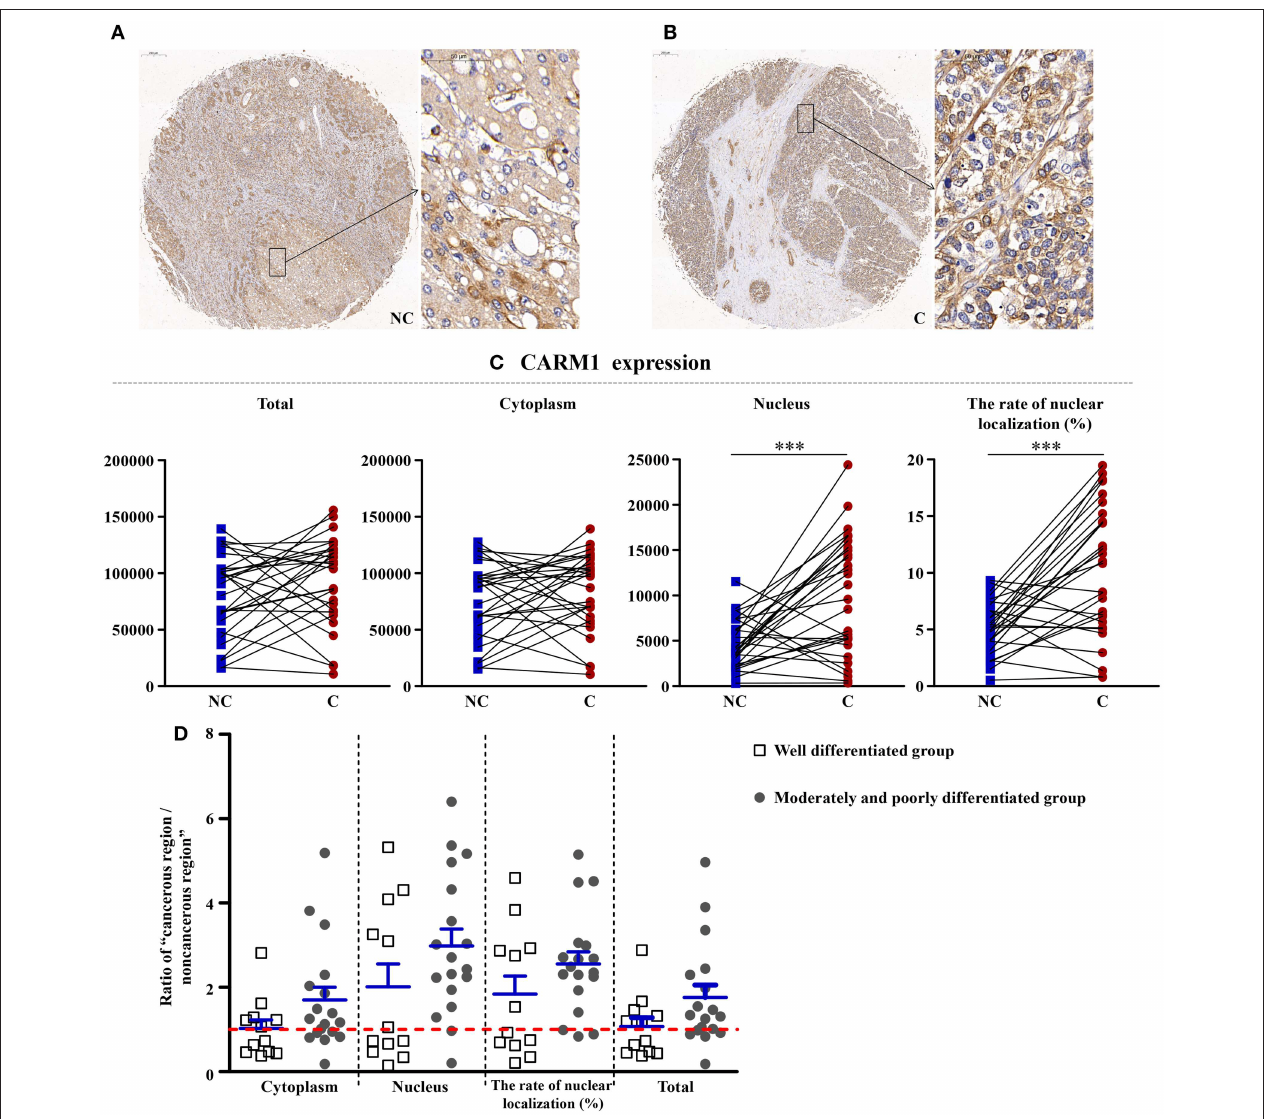
FIGURE 5 | The detailed expression of CARM1. Representative images of CARM1 protein expression in liver cancer’s corresponding (A) non-cancerous (NC) and (B) cancerous (C) regions. (C) Quantification of CARM1 expression (total, cytoplasmic, and nuclear expressions and the rate of nuclear localization) levels using multispectral image analysis in the liver cancer samples. (D) The ratio of “cancerous region/non-cancerous region” of CARM1 expression in two groups (well-differentiated group vs. moderately and poorly differentiated group). The red line indicates that the ratio is equal to 1. Scale bar: 200 or 50 µ m. ***Denotes significant differences from the well-differentiated group with P <